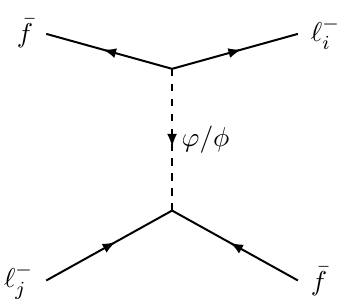
Figure 10. Demonstrative topology of the leading-order LQ contribution to muon-electron con- version in nuclei, where f 2 f u; d g .